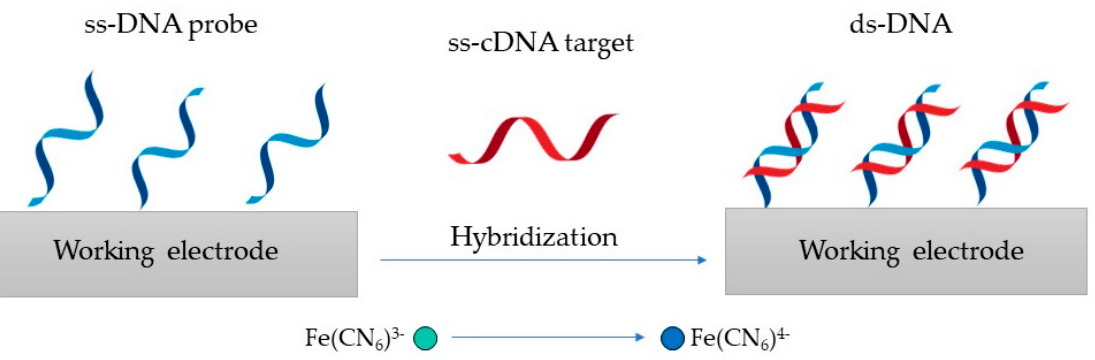
Figure 4. Genosensor principle, where the ss-DNA probe is hybridized with its ss-cDNA to produce ds-DNA.